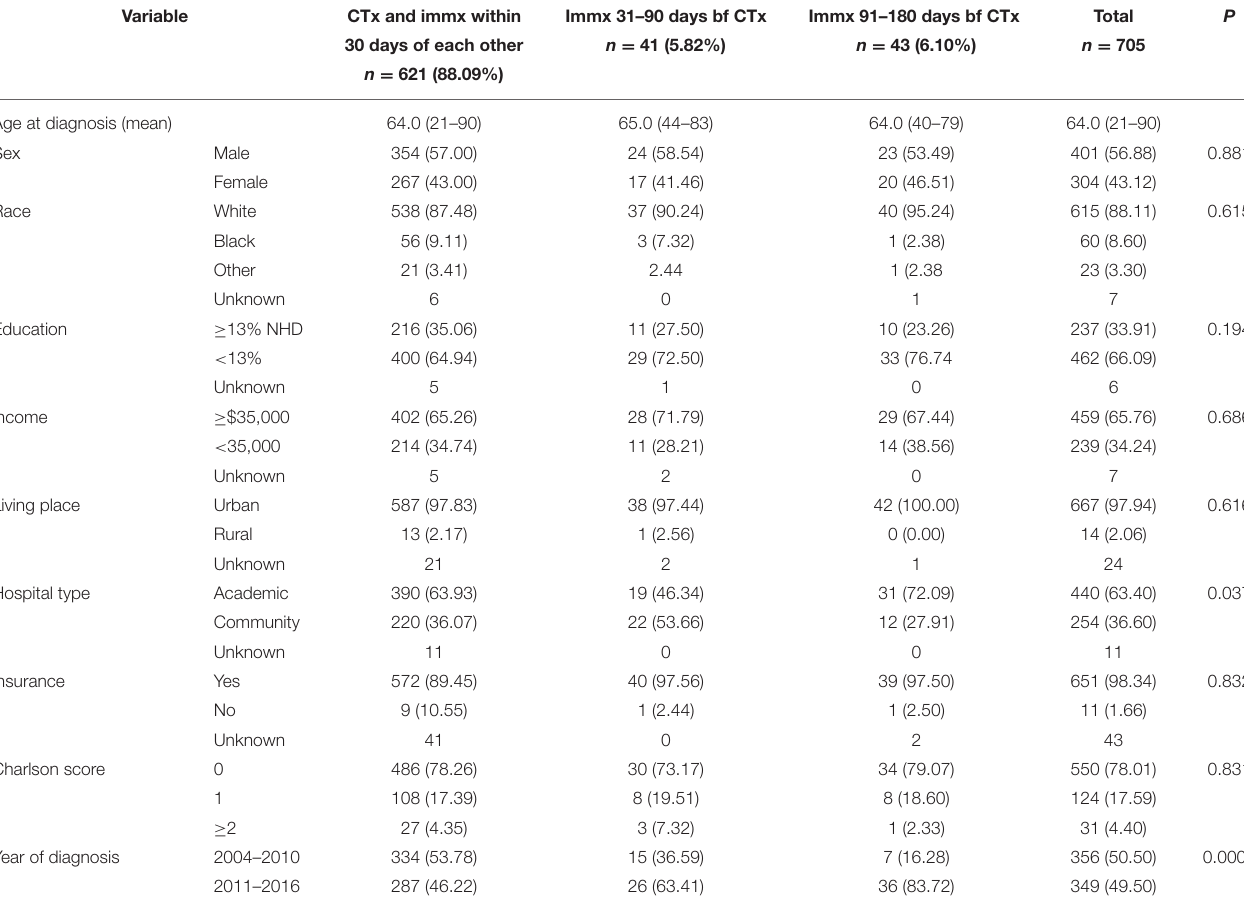
TABLE 1 | Baseline characteristics of the sequence of immunotherapy with chemotherapy in PDAC patients with no